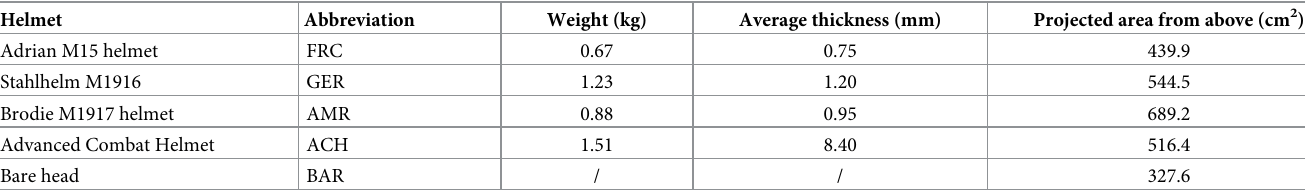
Table 1. Helmet abbreviations and